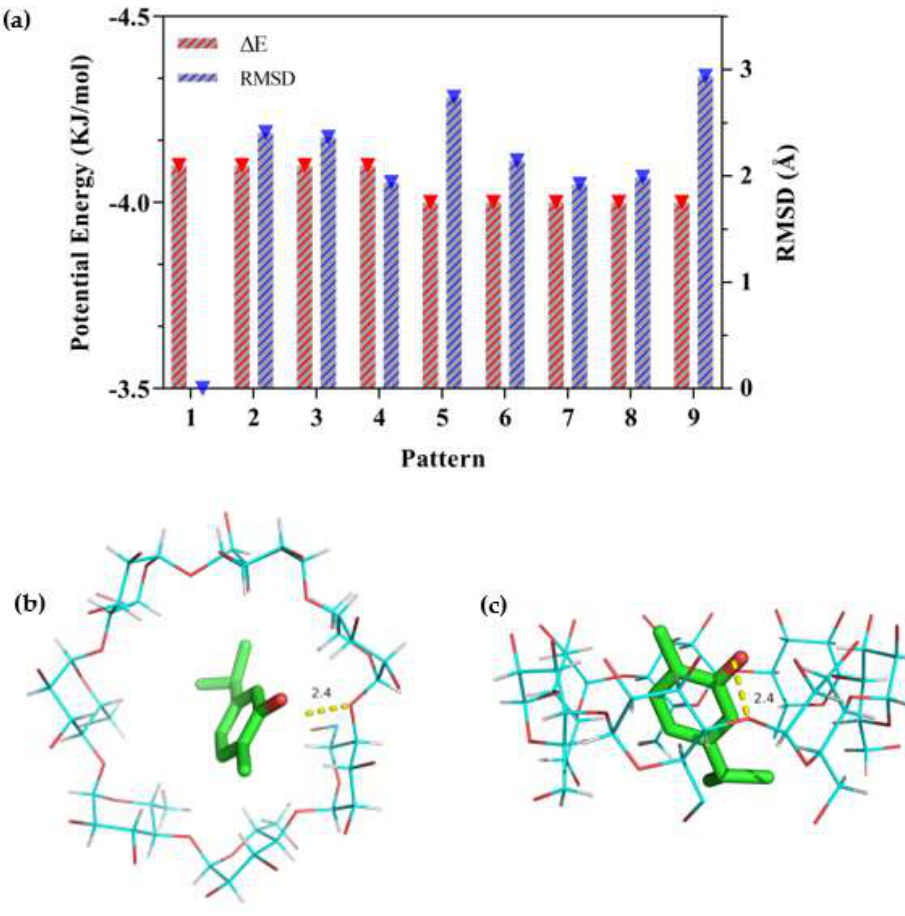
Figure 8. Docking scores of carvacrol in the inner cavity of β − CD. ( a ) The different values of ∆ E and RMSD at nine patterns; ( b ) Docked pose of best − ranked docking score (top view); ( c ) Docked pose of best − ranked docking score (side